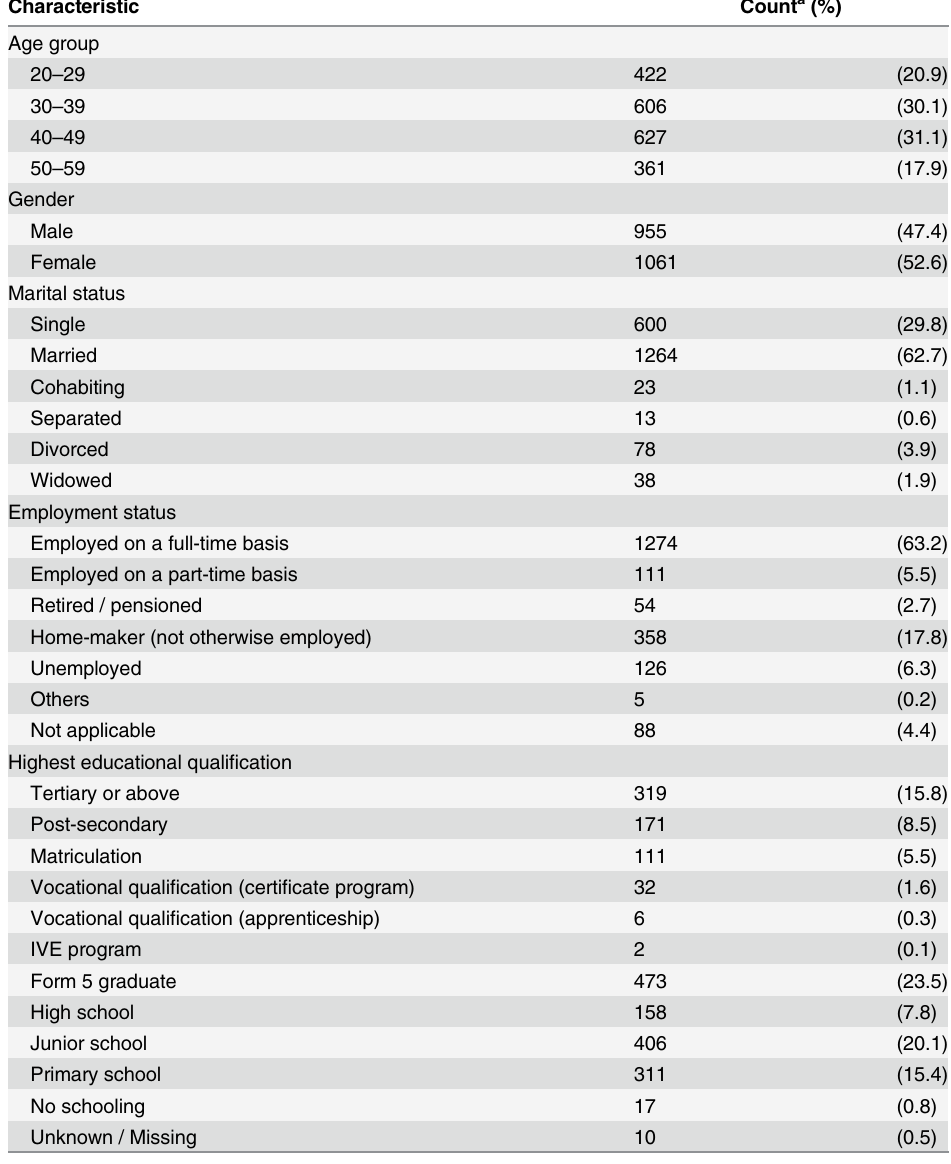
Table 1. Characteristics of Participants in the Present Study (Count,